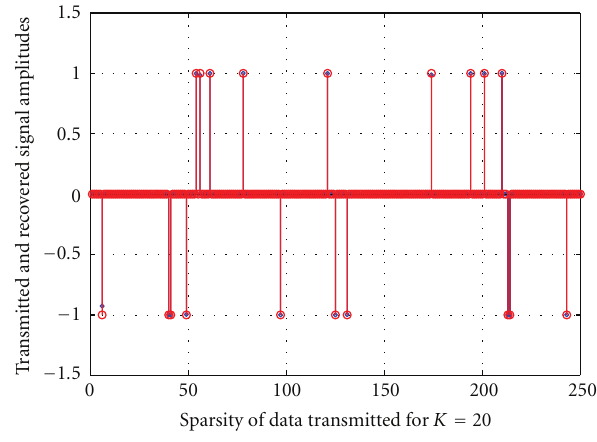
Figure 13: Sparsity of data transmitted for K =